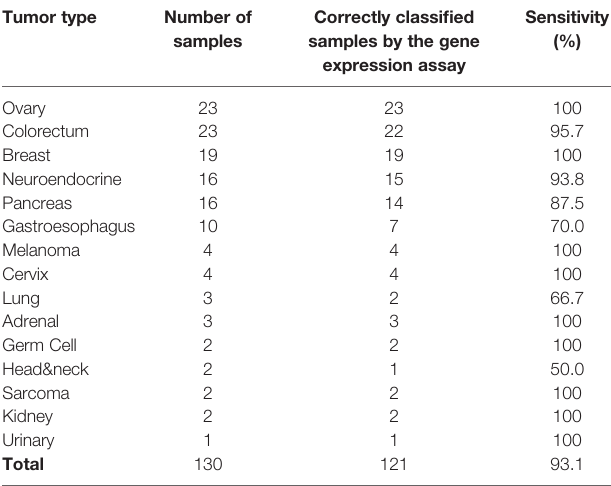
TABLE 2 | The performance of the 90-gene expression assay in liver metastases.